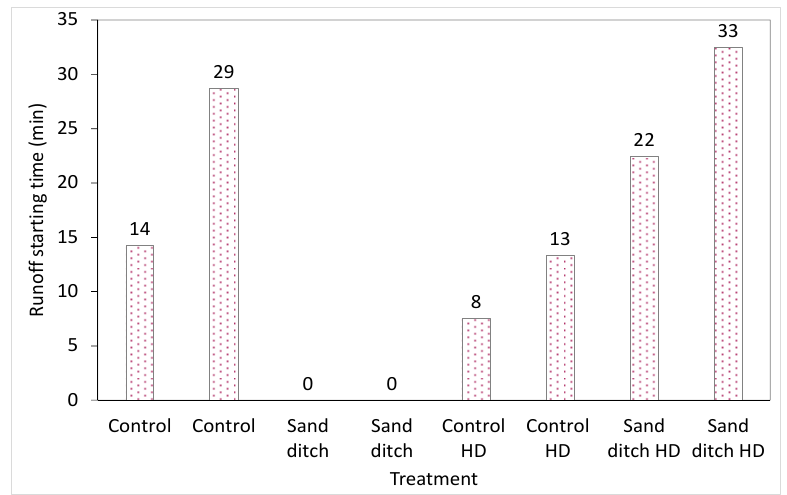
Figure 7. Runoff starting time at the downslope outlet of the soil box after introducing inflow water at the upslope edge for low density and compacted high-density soil.